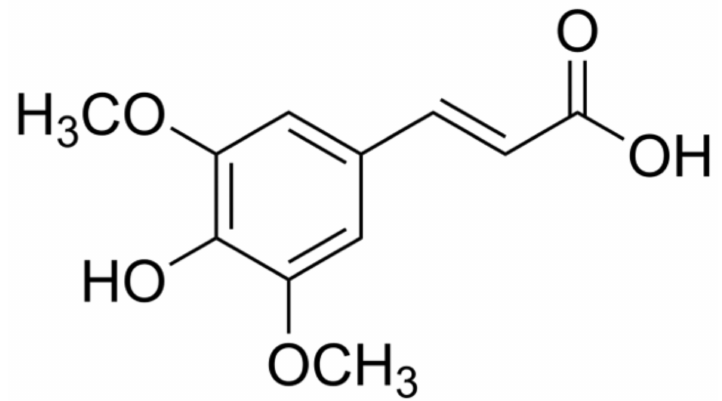
Figure 1. Chemical structure of sinapic